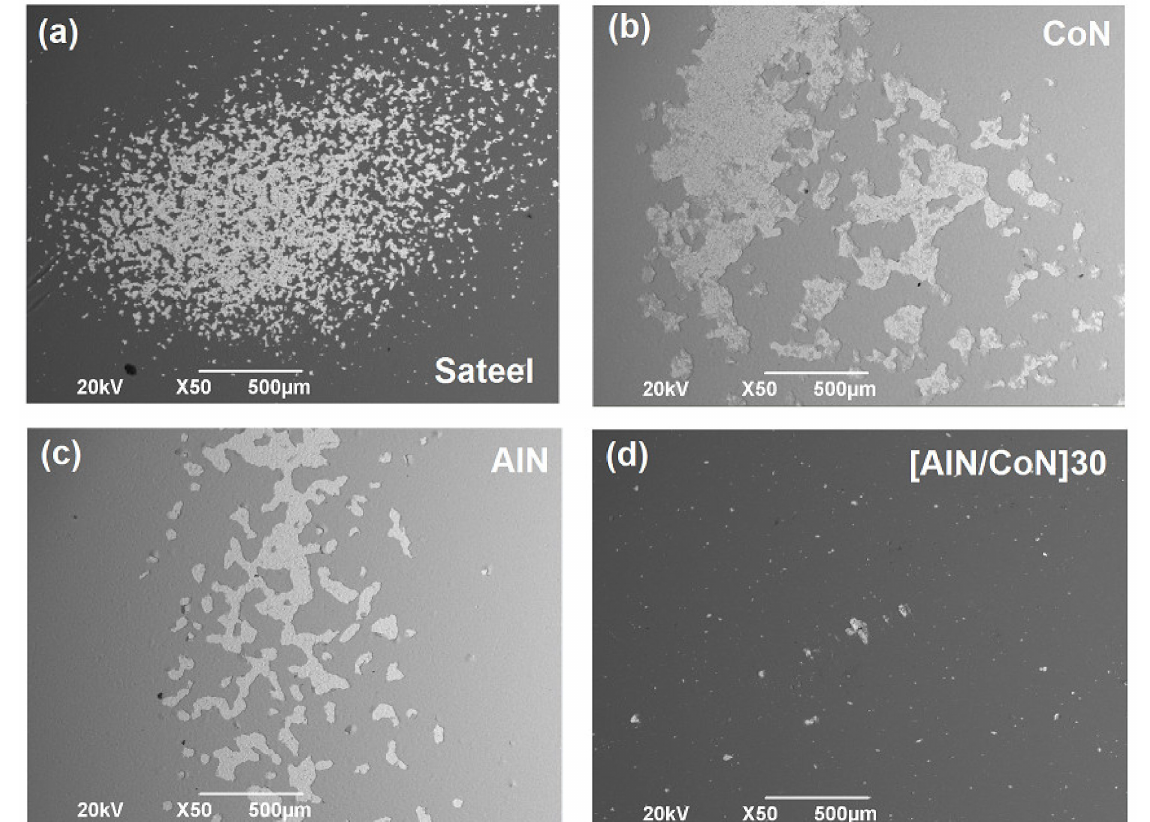
Figure 15. SEM micrographs of the corrosive process for uncoated and coated steel substrates: ( a ) uncoated stainless steel,